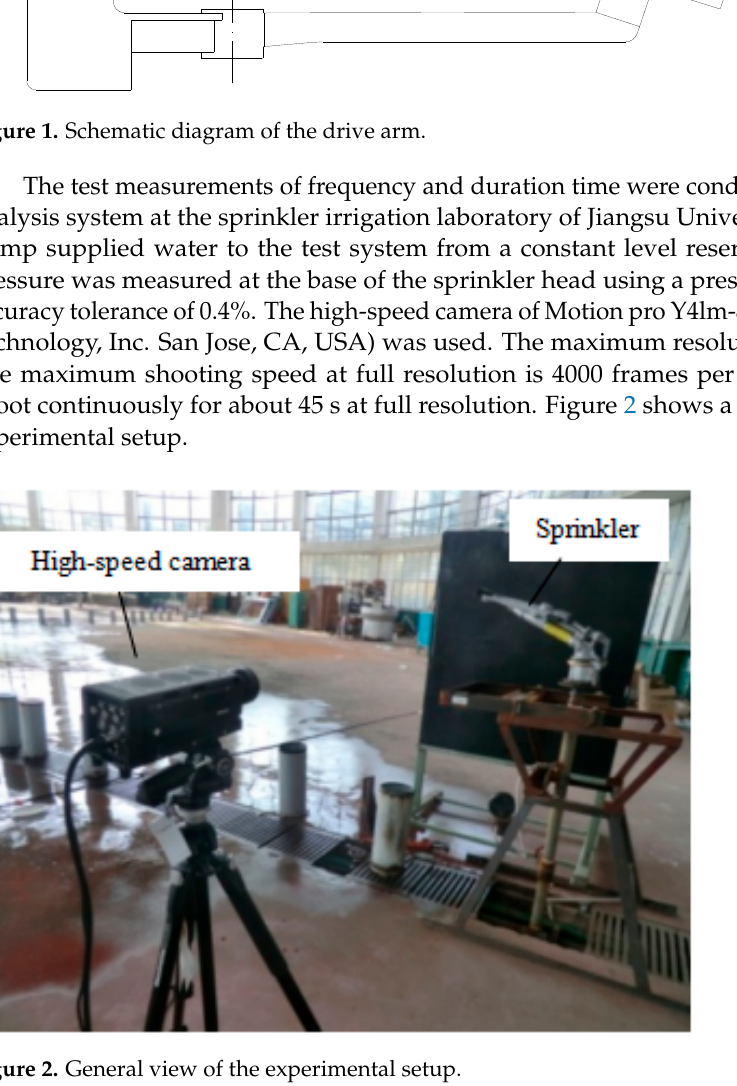
Figure 2. General view of the experimental setup.